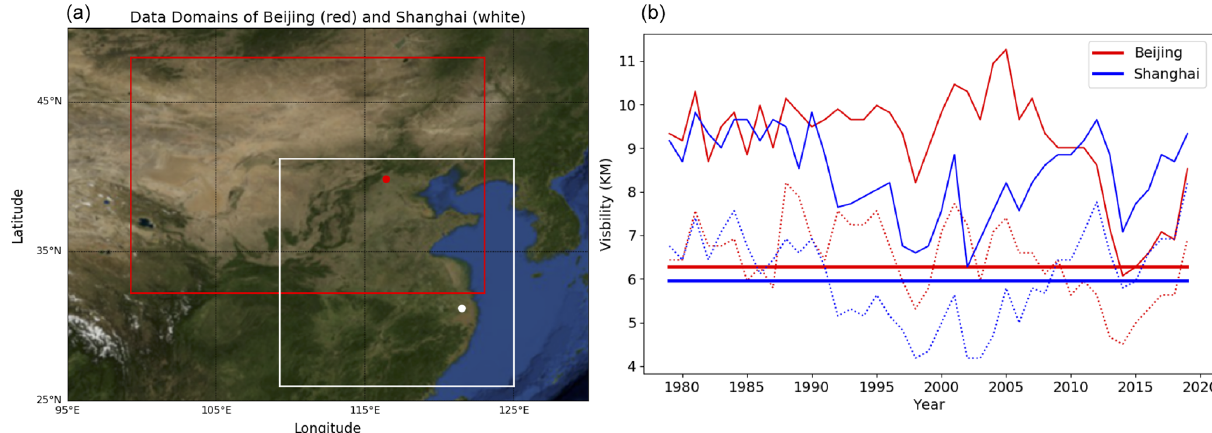
Figure 2. (a) The input feature defining domains for Beijing (red box and dot, 32.25–48 ◦ N, 99.25–123 ◦ E; 64 × 96 grids with ERA5 data) and Shanghai (white box and dot, 26–41.25 ◦ N, 109.25–125 ◦ E; 64 × 64 grids), made using the Basemap library (a Matplotlib extension). (b) Annual means (solid curves), 25th percentiles (dashed curves), and 25th percentile means (solid straight lines) of surface visibility in Beijing (red) and Shanghai (blue) between 1979 and